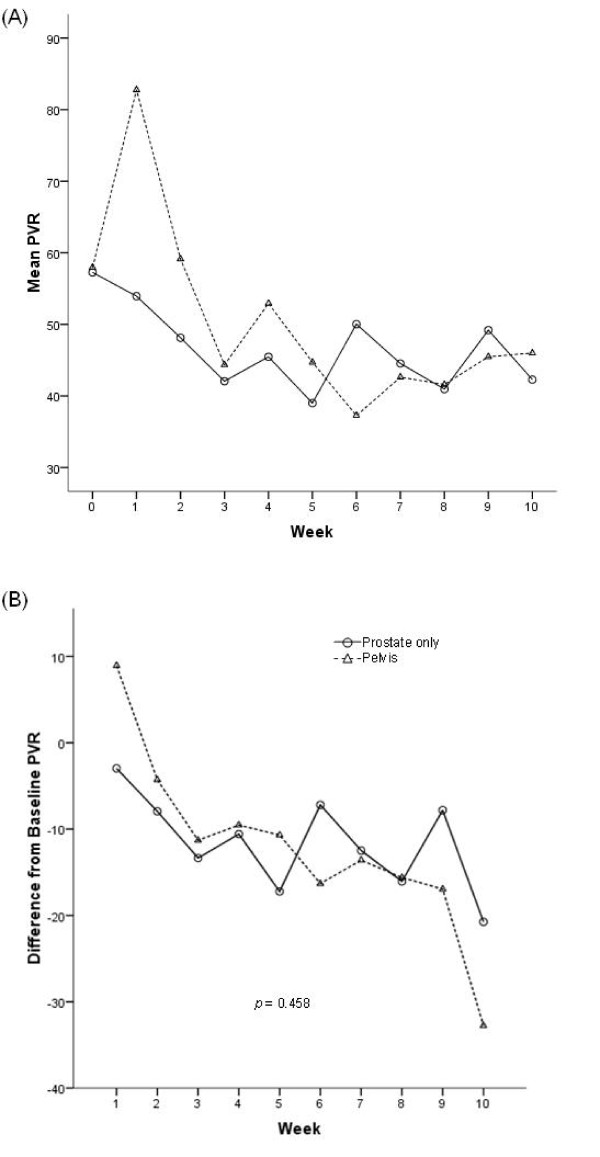
(A). Mean post-void residual volume as a function of week of external beam radiation therapy (XRT) treatment, stratified by radiation group. The bladder scanner operates within a margin of accuracy of ± 20 cc. (B) Mean difference from baseline in post-void residual (PVR) volume as a function of week of external beam radiation therapy (XRT) treatment, stratified by radiation group. The best-fit lines were determined by quadratic regression analysis. The bladder scanner operates within a margin of accuracy of ± 20 cc.